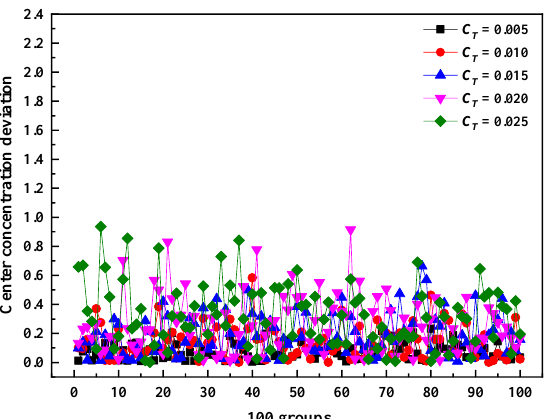
Figure 14. Center concentration deviation under the different relative standard deviations of tem- peratures at velocity 2.1 m/s.